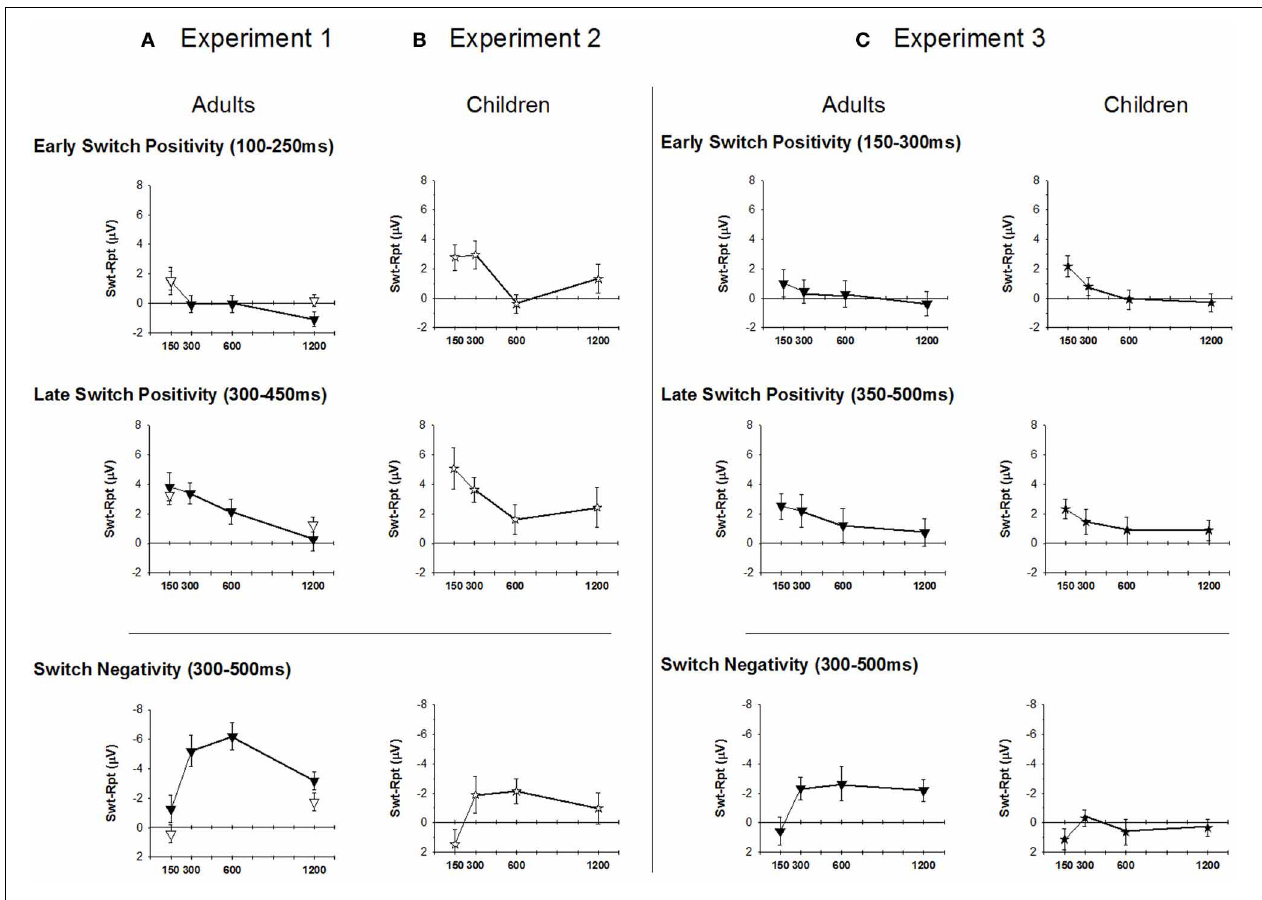
FIGURE 4 | Mean amplitude of early and late switch-positivity from response-locked ERP waveforms (top and middle panels) and switch-negativity from stimulus-locked ERP waveforms (bottom